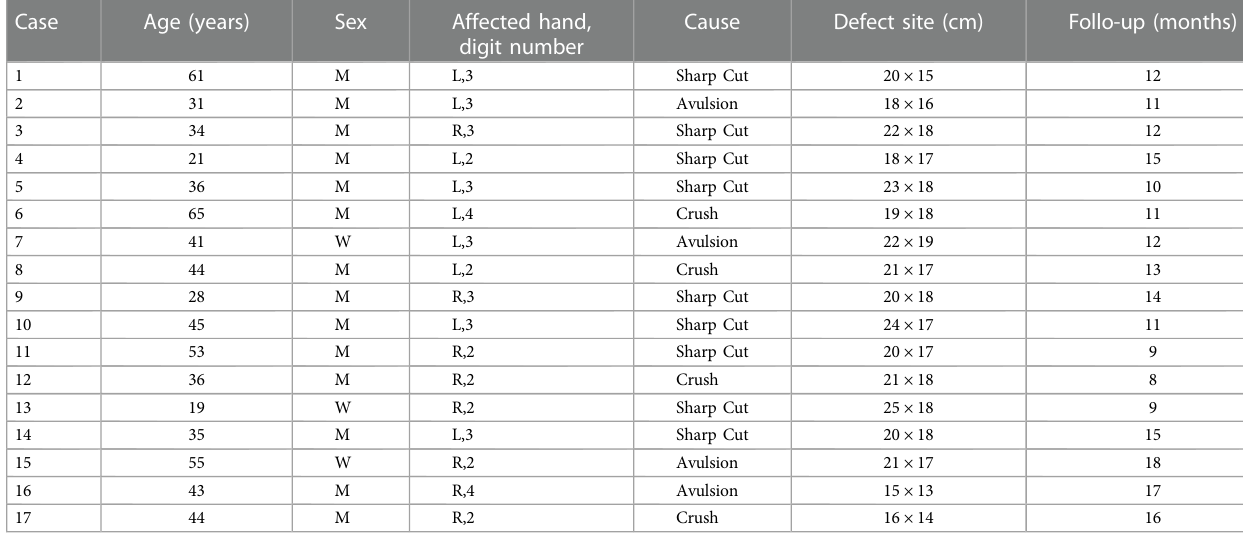
TABLE 1 Patient demographics and surgical